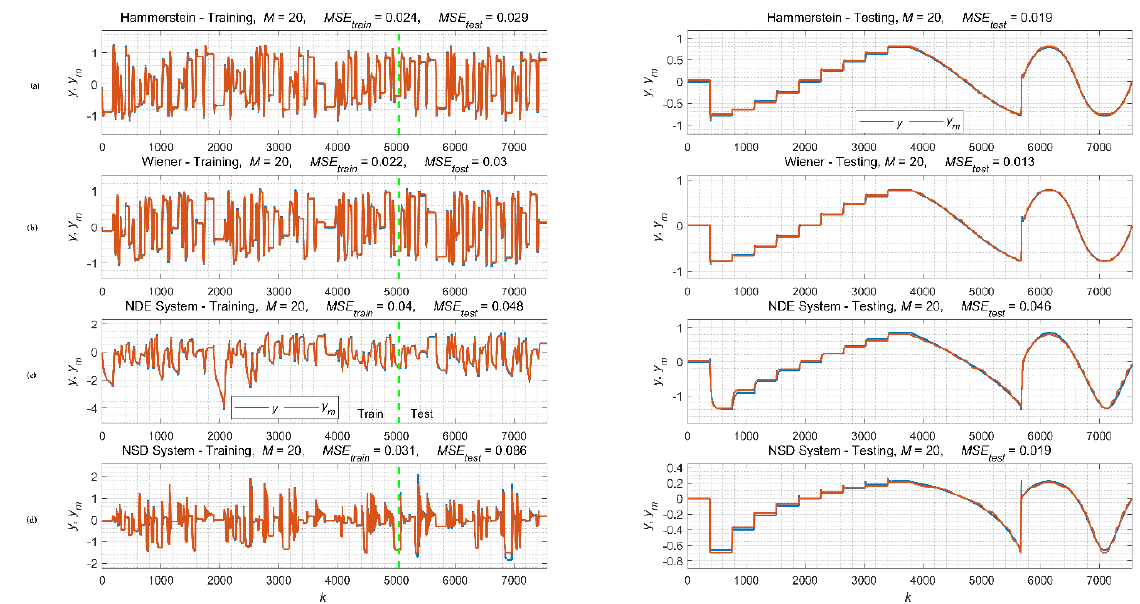
Figure 10. Comparison between desired outputs y and predicted outputs y m for the nonlinear dynamic test processes: ( a ) Hammerstein, ( b ) Wiener, ( c ) NDE, and ( d ) NSD. The left-hand side shows the training data session results, and the right-hand side the test data session results.